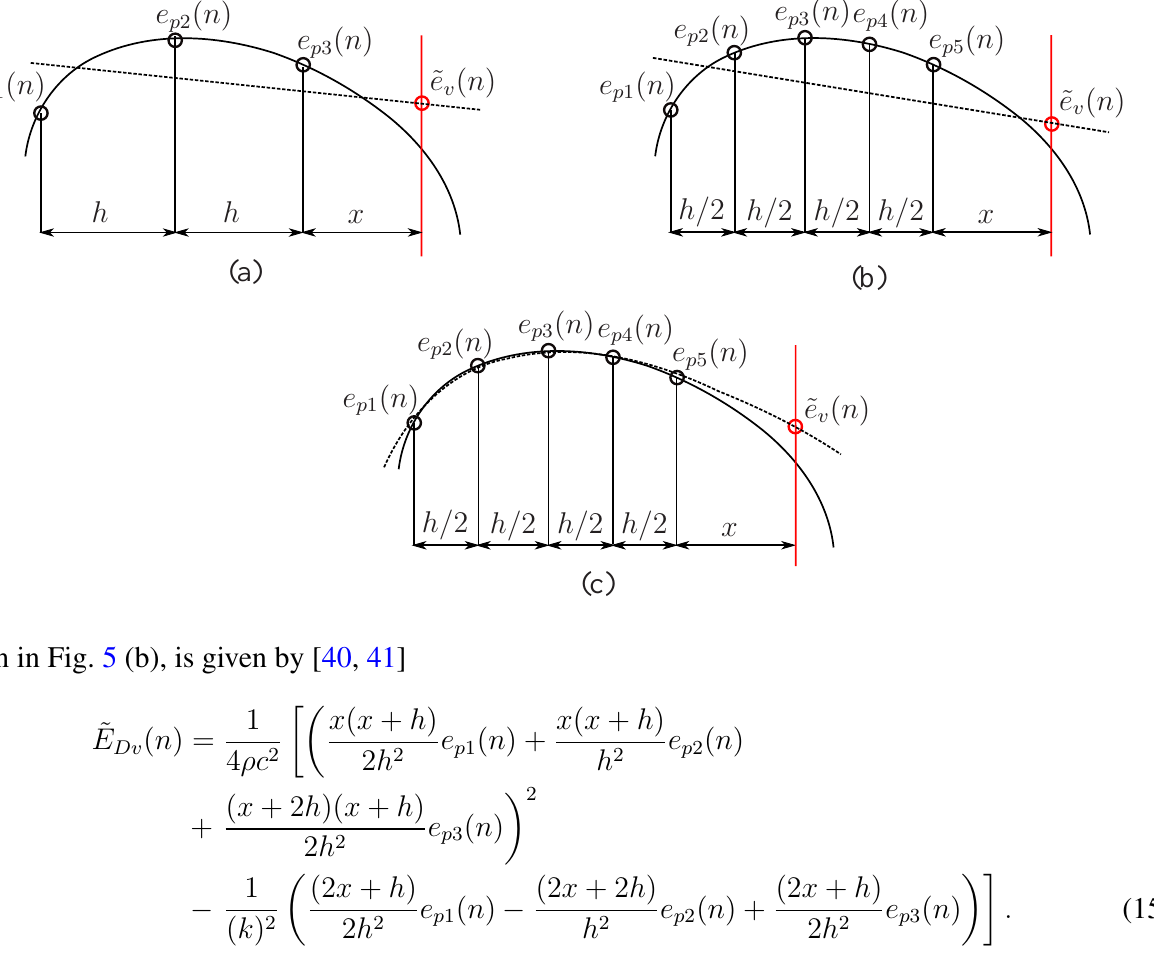
Figure 6 . Diagram of (a) three microphone linear forward difference extrapolation; (b) five microphone linear forward difference extrapolation; and (c) five microphone quadratic forward difference extrapola- tion. The black curved line represents the actual pressure field and the dashed line represents the pressure